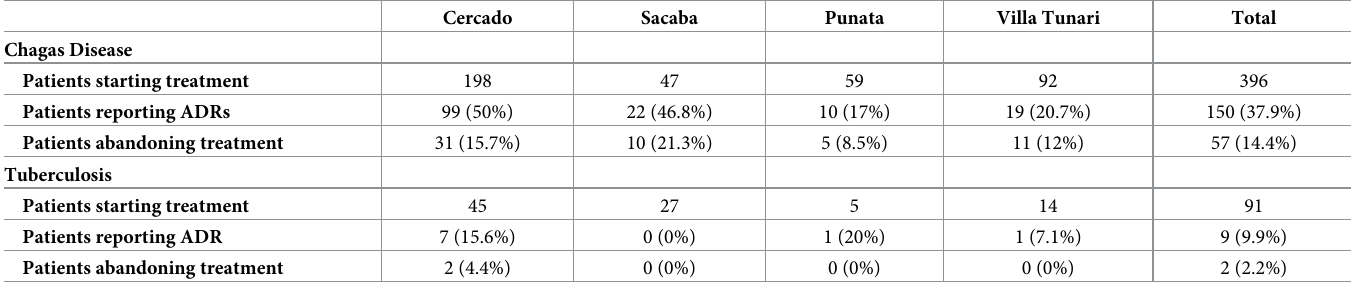
Table 1. Total patients starting treatment, reporting ADRs, and abandoning treatment for CD and TB in the Bolivian Chagas Platforms and the primary and sec- ondary national healthcare centers located in the Department of Cochabamba and included in the study. Data are shown by geographical area. Cercado Sacaba Punata Villa Tunari Total Chagas